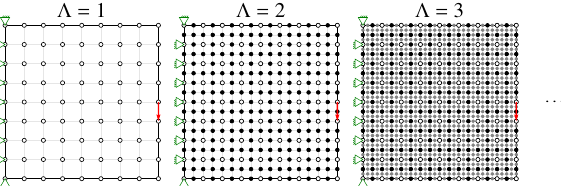
Figure 4. Nodes and elements at different levels Λ (resolutions). The boundary conditions do not